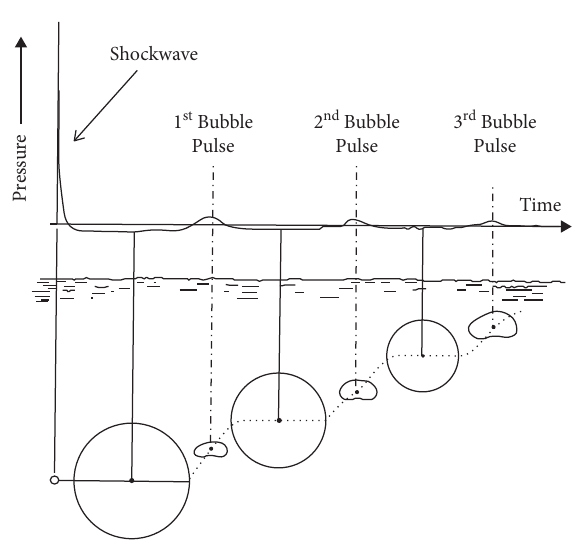
Figure 16: UNDEX gas dynamics [40].